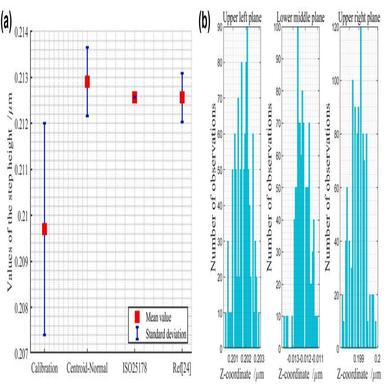
Comparison of results in Experiment 3: (a) Step heights computed by each method; (b) Distribution of the Z-coordinate values of the evaluation planes.